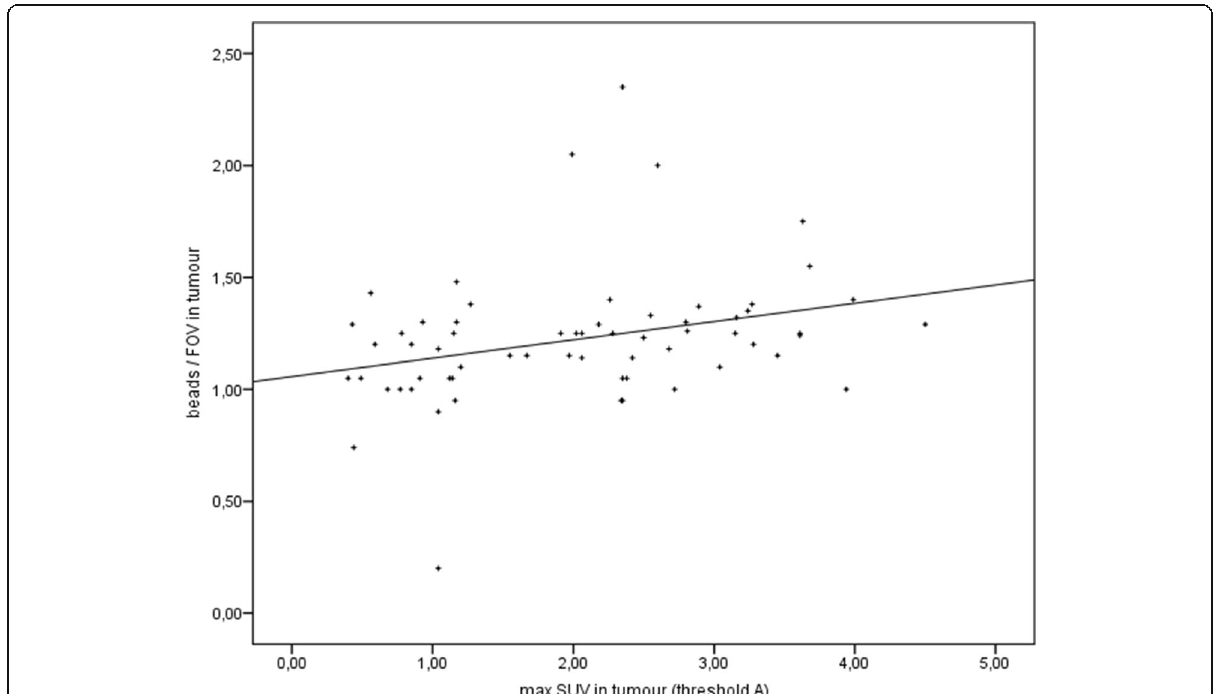
Fig. 8 Correlation. Spearman ’ s rank correlation between the maximal SUV in [18F]FDG-PET and the fluorescent beads (histology, [beads/FOV]); r = 0.353, p = 0.005)